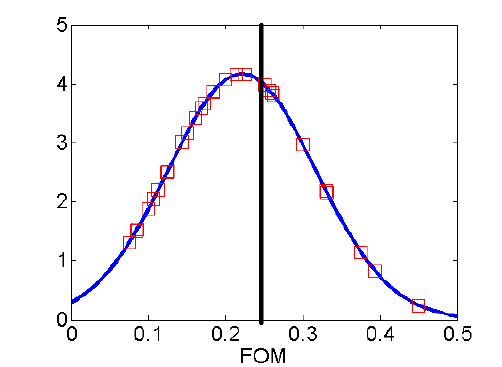
Figure 7. The comparison of the sensor figure-of-merit (FOM) with commercial sensors. All data points are fitted in a Gaussian distribution, with mean 0.221 and a standard deviation of 0.096. Squares are FOM from commercial sensors, and the black line indicates the FOM of the designed